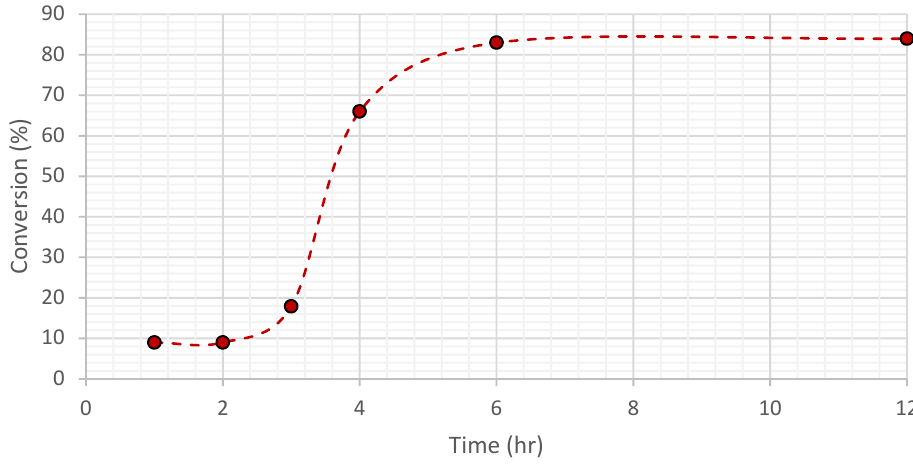
Figure 12. Effect of irradiation time on the oxidation of VAL using NiFe 2 O 4 .